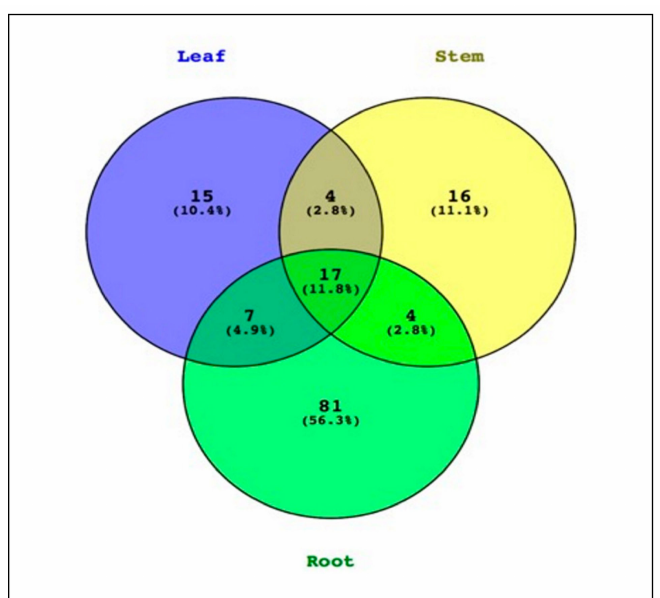
Figure 2. Venn diagram showing endophytic bacteria OTUs in di ff erent plant tissues of Pseudowintera colorata . The total observed OTUs from QIIME were processed in VENNY (http: // bioinfogp.cnb.csic.es / tools / venny / index.html).